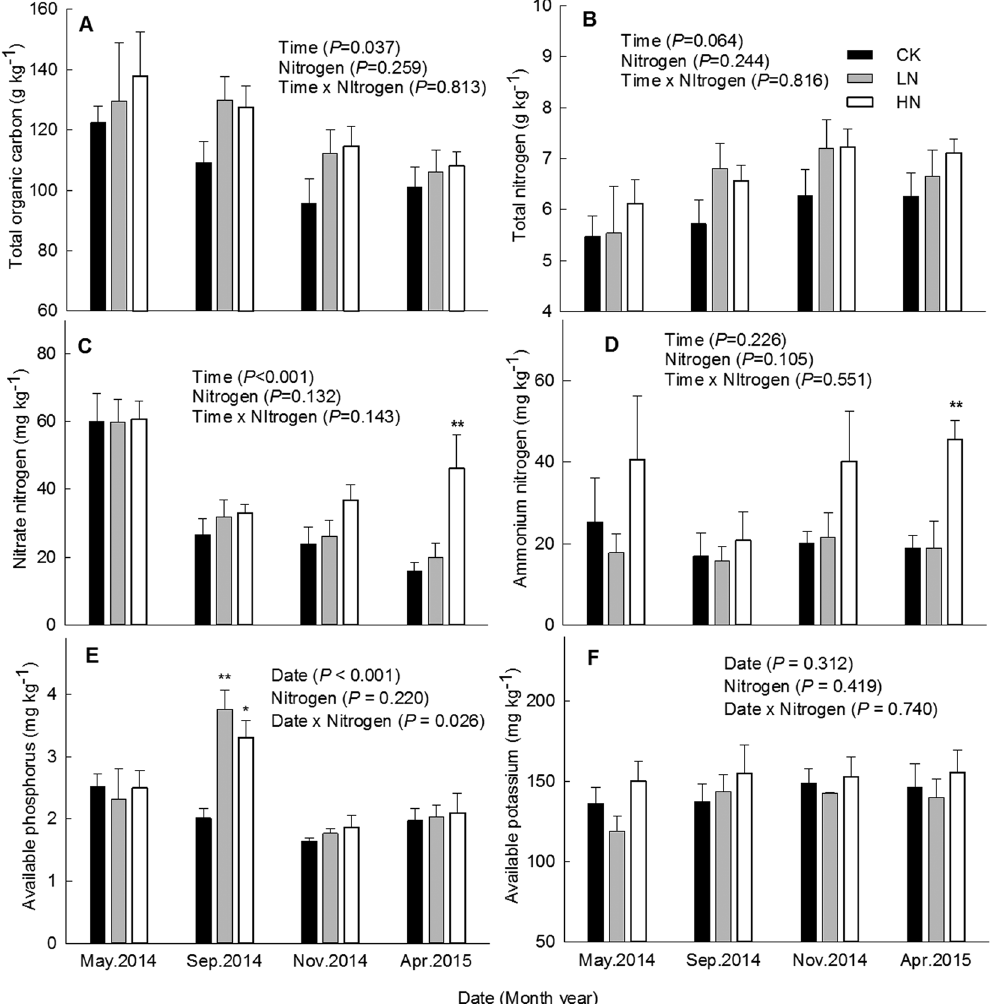
Figure 2. Soil nutrient availability under different nitrogen treatments in a secondary evergreen broad-leaved forest ecosystem, southwestern China. Values are means ± 1 SE. Error bars indicate ± 1 SE, N = 3. The results of repeated measures ANOVAs are shown for each parameter. Asterisk ( * ) indicate a significant difference between the control and experimental N treatment at P < 0.05; double asterisks ( ** ) indicate a significant difference between the control and experimental N treatment at P < 0.01.